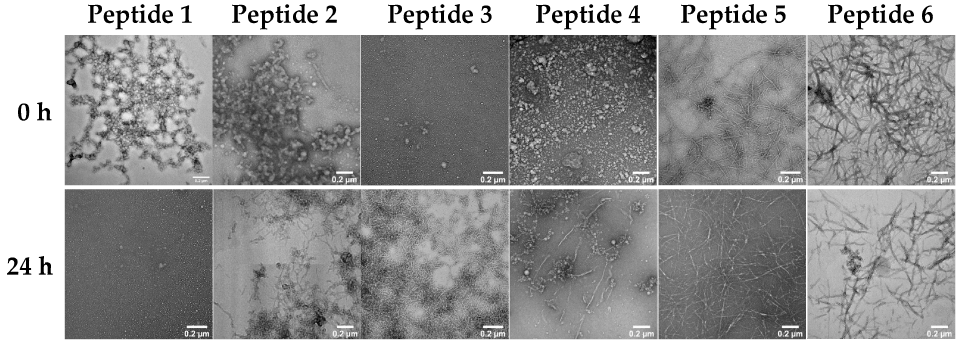
Figure 4. Transmission electron microscopy images of peptides at 0 h and after 24 h of incubation. Scale bars represent 0.2 µ m. Peptide 1 = IFYCPIAIM; Peptide 2 = NIFYCPIAIM; Peptide 3 = VLVNAIVFKGL; Peptide 4 = YCPIAIMSA; Peptide 5 = MMYQIGLF; Peptide 6 = VYSFSLASRL.